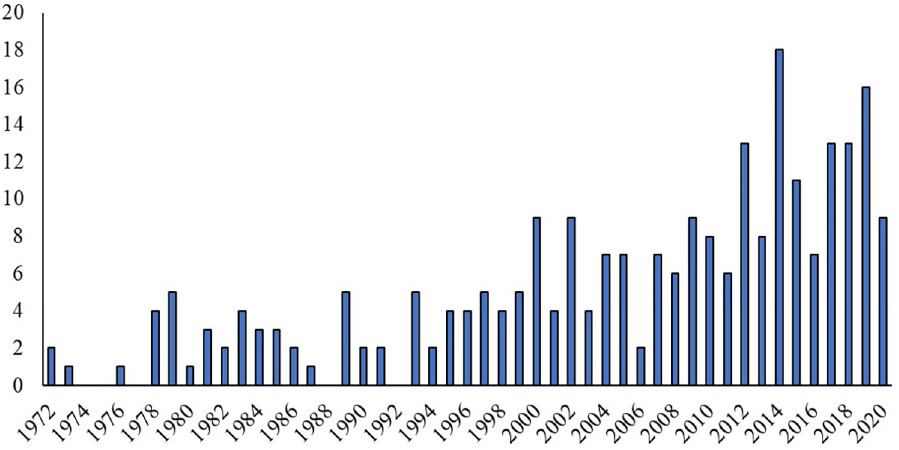
Fig 2. The number of studies on colostrum characteristics and management practices on transfer of passive immunity in dairy calves published each year between 1972 and 2020 (n = 256).